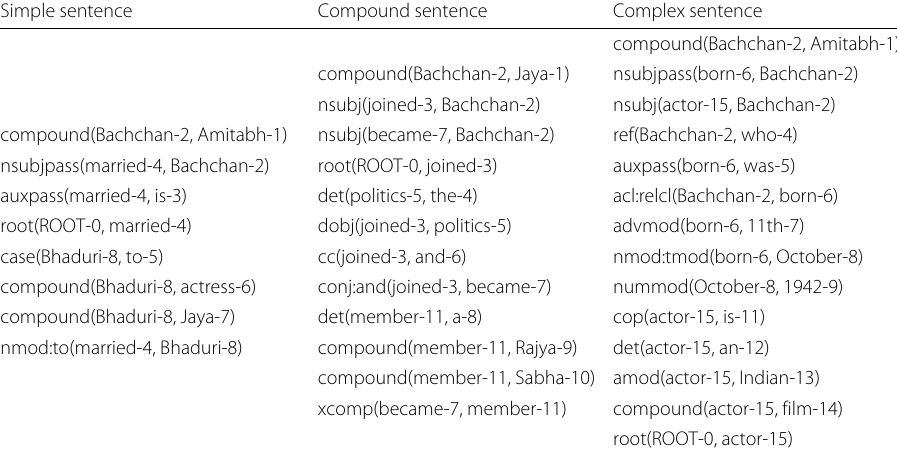
Table 1 Stanford typed dependency of the three sample sentences Simple sentence Compound sentence Complex sentence